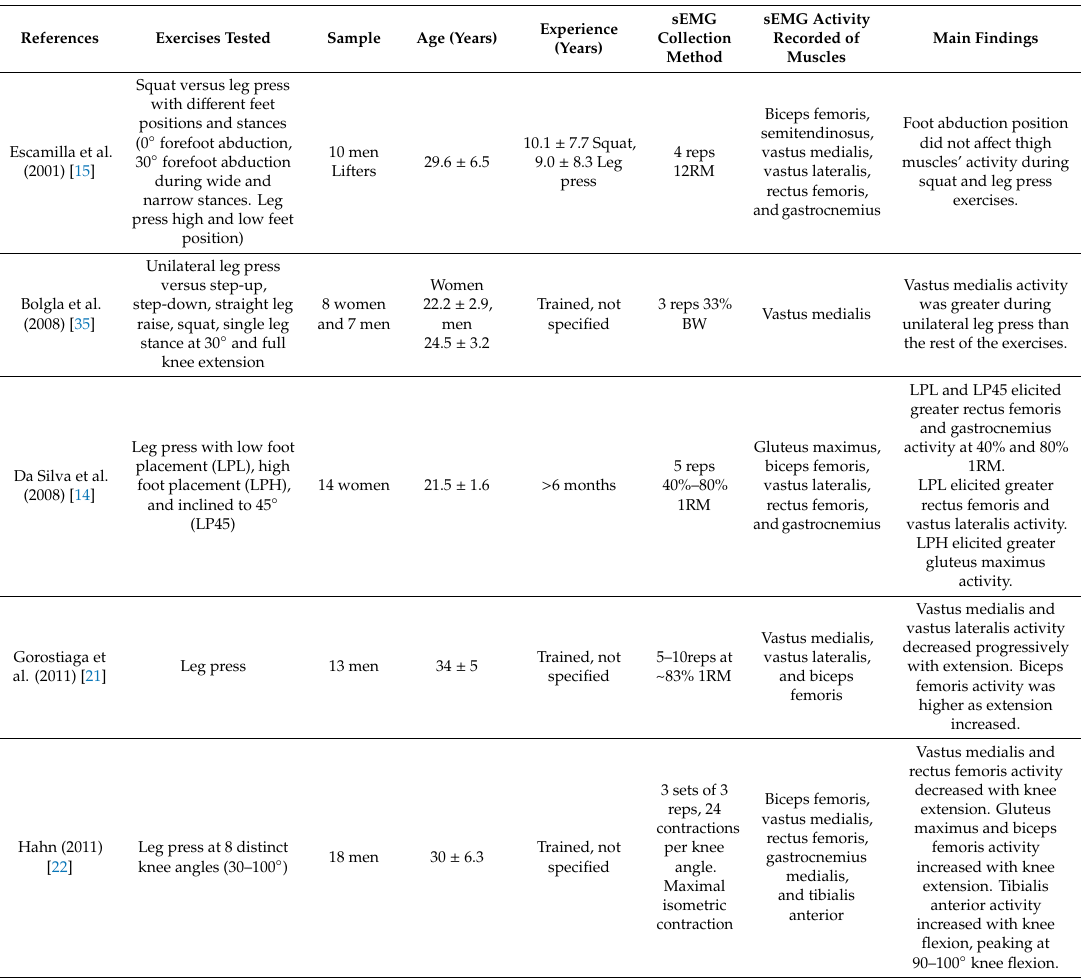
Table 1. General data regarding the exercises tested, the sample size, the participants’ gender and age, the training experience time, the surface electromyography (sEMG) collection method, the outcomes, and the main findings of the selected